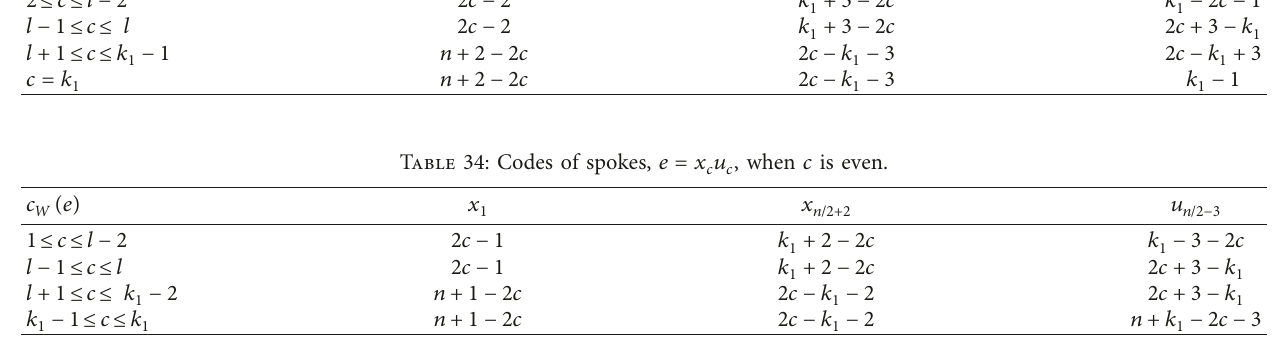
Table 33: Codes of spokes, e � x